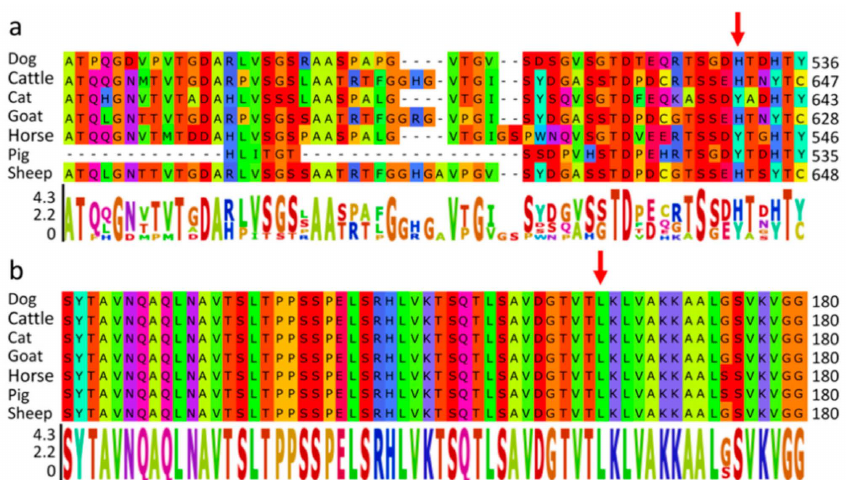
Figure 2. Cross-species comparison of variant amino acid positions in HEG1 and KLF7. Partial protein sequences of HEG1 ( a ) and KLF7 ( b ) flanking the variant amino acid positions were aligned using ClustalW (https://www.ebi.ac.uk/Tools/msa/clustalo/ (accessed on 24 March 2021)). The variant positions are highlighted with a red arrow. Residual color scheme was referred from [38], sequence logos are shown according to